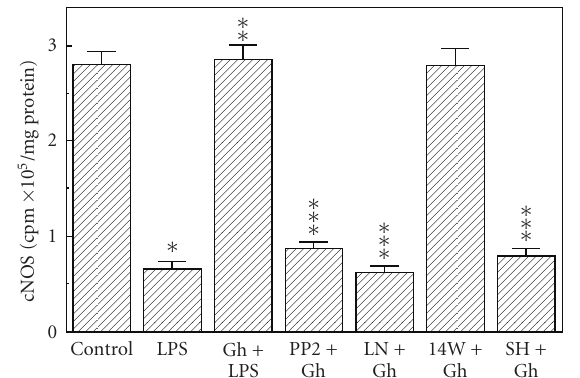
Figure 4: E ff ect of ghrelin on H. pylori LPS-induced expression of NOS-2 and cNOS activities in gastric mucosal cells. The cells, preincubated with the indicated concentrations of ghrelin, were treated with the LPS at 100 ng/mL and incubated for 16h. Values represent the means ± SD of five experiments. ∗ P < . 05 compared with that of control. ∗∗ P < . 05 compared with that of LPS alone.